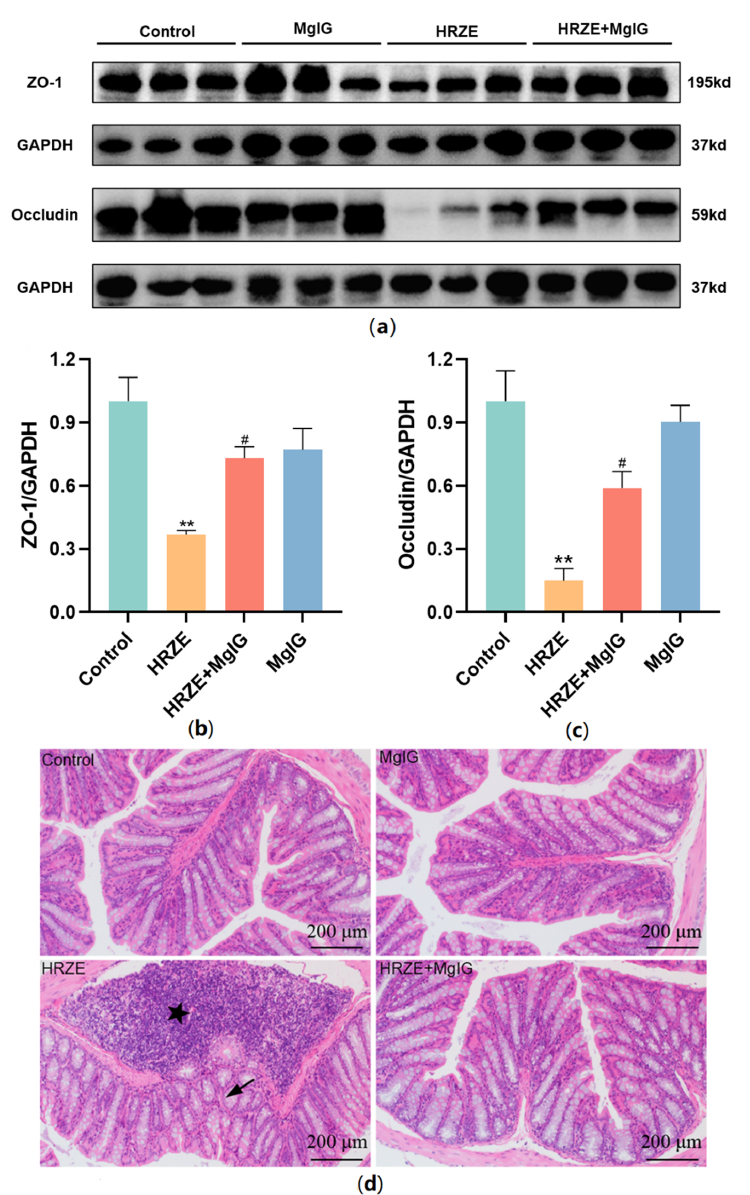
Figure 4. MgIG improves HRZE-induced intestinal barrier function. ( a ), ( b ) and ( c ) The protein levels of ZO-1 and occludin in colon tissues were analyzed by Western blot assays ( n = 3 per group); ( d ) representative images of colon H&E staining in each group—the asterisk means inflammatory cell infiltration and the arrow means significantly shorter crypt depth. The data are presented as the means ± SEM. Compared with the control group: ** p < 0.01. Compared with the HRZE group: # p < 0.05.